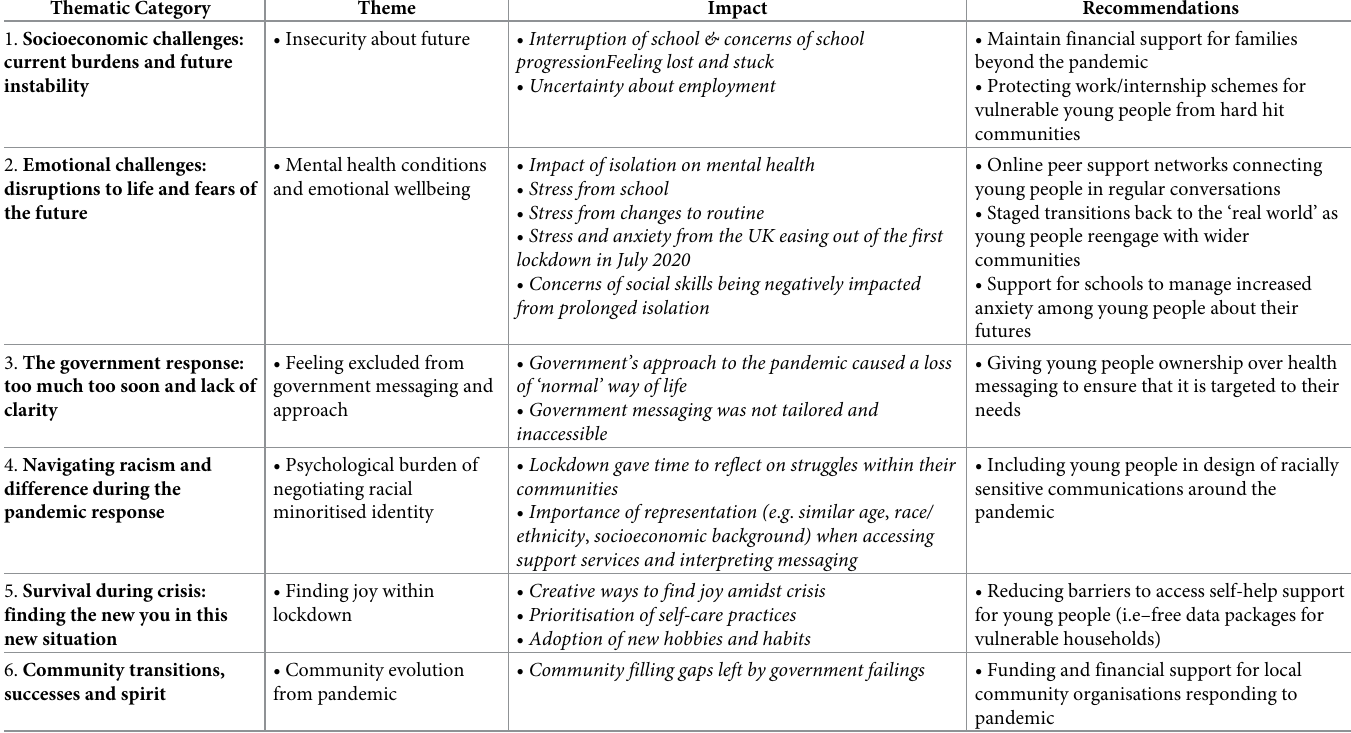
Table 3. From struggles to solutions–recommendations to support emotional wellbeing of young Black and minoritised young people in during and post- pandemic. Thematic